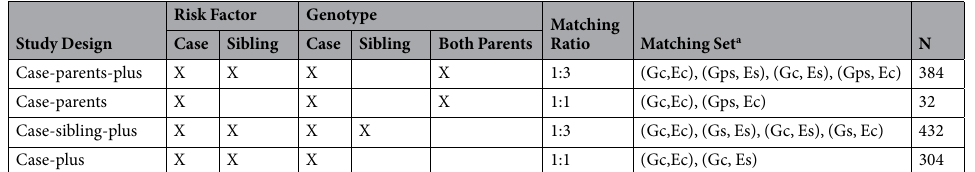
Table 1. Four families structures. “X” in the table denote the corresponding data are available. a Gc, Gs and Gps denote the genotypes of the case, sibling and pseudo-sibling (see text) respectively. Ec and Es denote the exposure (risk factor) of the case and sibling